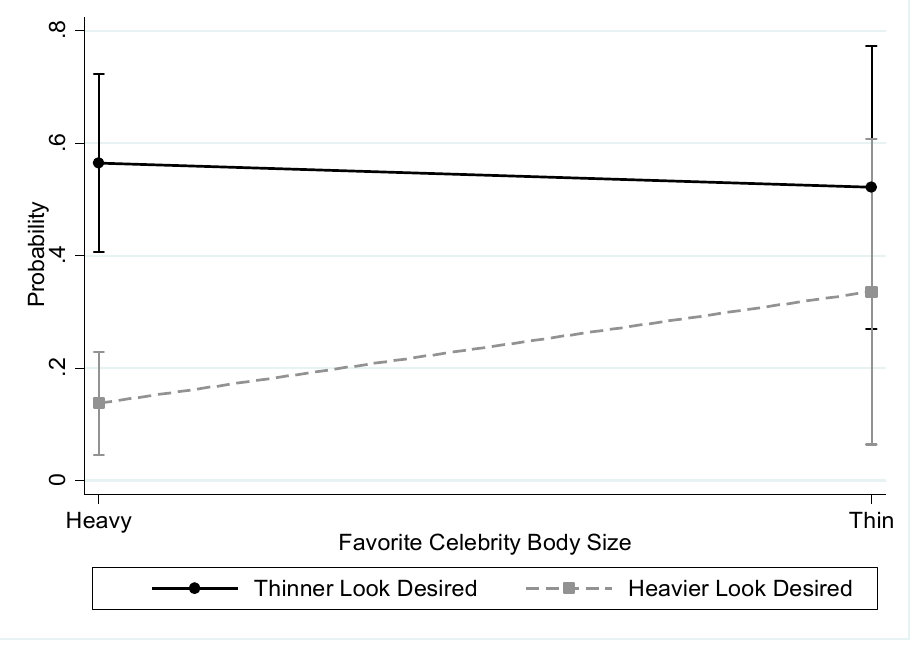
Figure 1. Predictive Margins for Thin Celebrities Treatment and Favorite Celebrity Body Size (Thin versus Heavy).